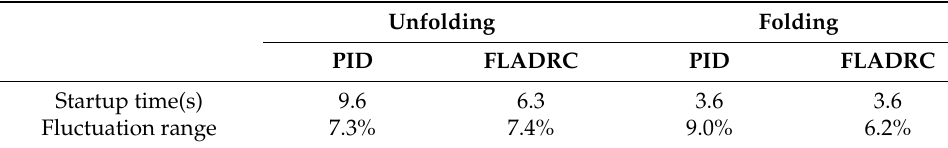
Table 3. Assessment indices of cylinder#1 motion control using PID and FLADRC.